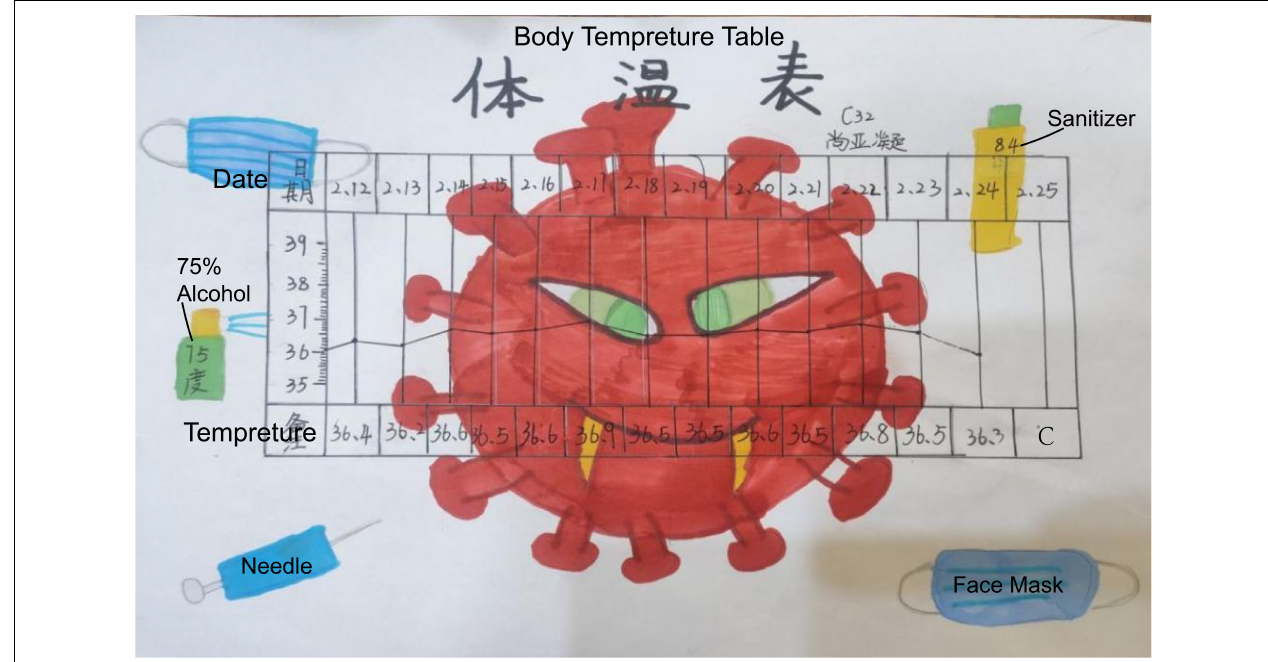
FIGURE 3 | Polyline statistical of body temperature recorded by one